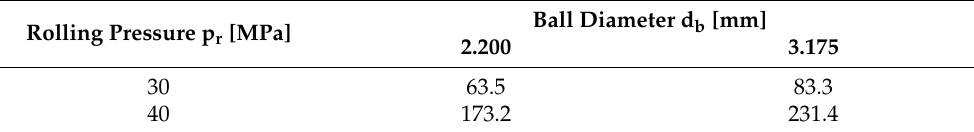
Table 4. Experimentally measured process forces F r [N] used in the simulation. Rolling Pressure p r